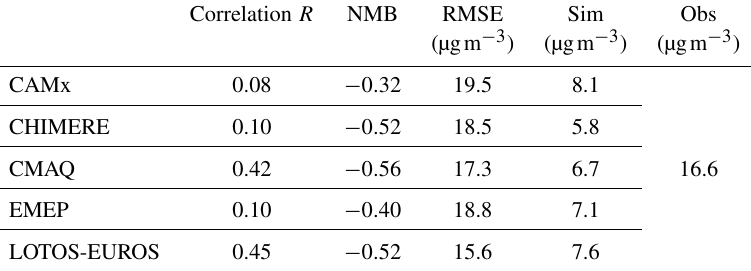
Table 3. Correlation, normalized mean bias (NMB), root mean square error (RMSE), and observational (obs) and simulated (sim) mean values of NO 2 for 2015: first data were averaged station-wise and then averaged for all 62